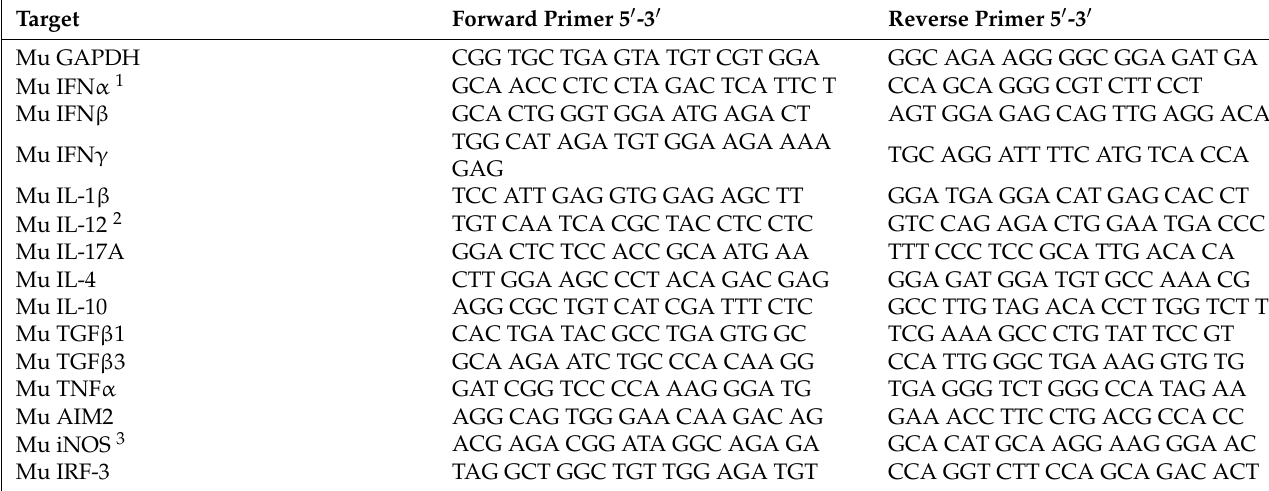
Table 1. Sequences of the